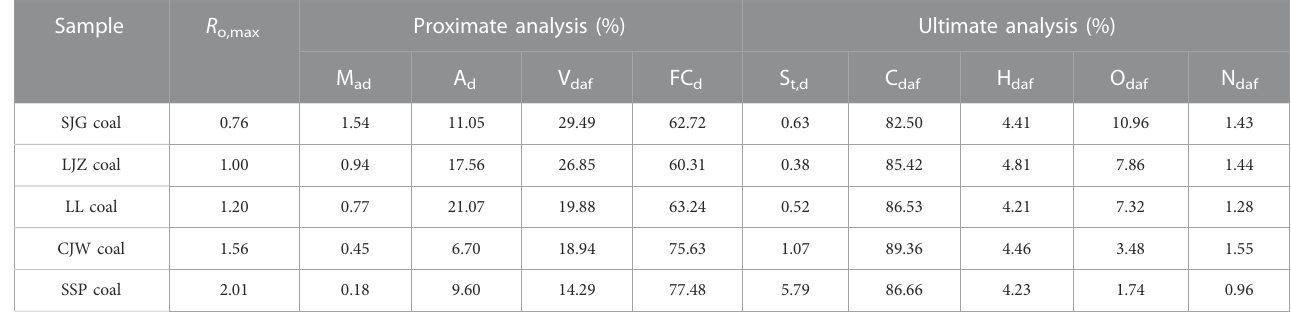
TABLE 1 The results of R o,max proximate analysis and ultimate analysis.